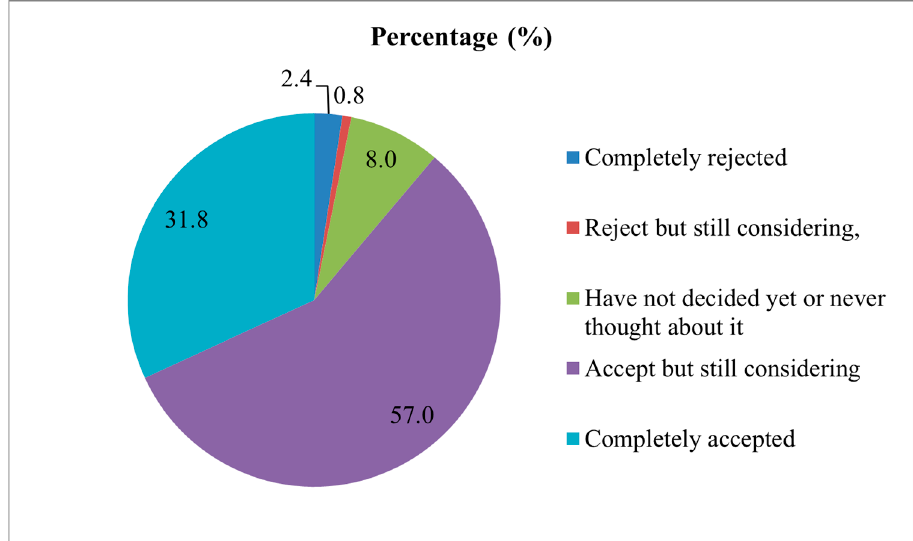
Figure 1. Proportion of influenza vaccine hesitancy in community healthcare workers.